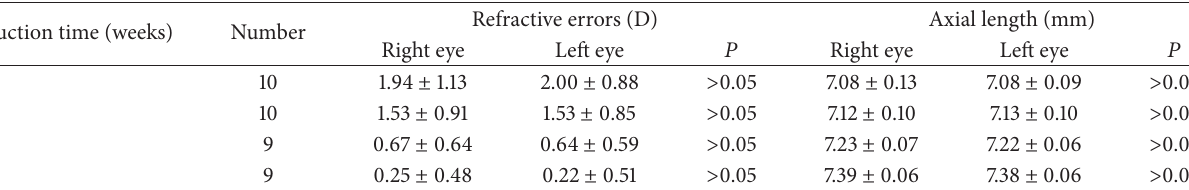
Table 2: The refractive errors and axial length in NC